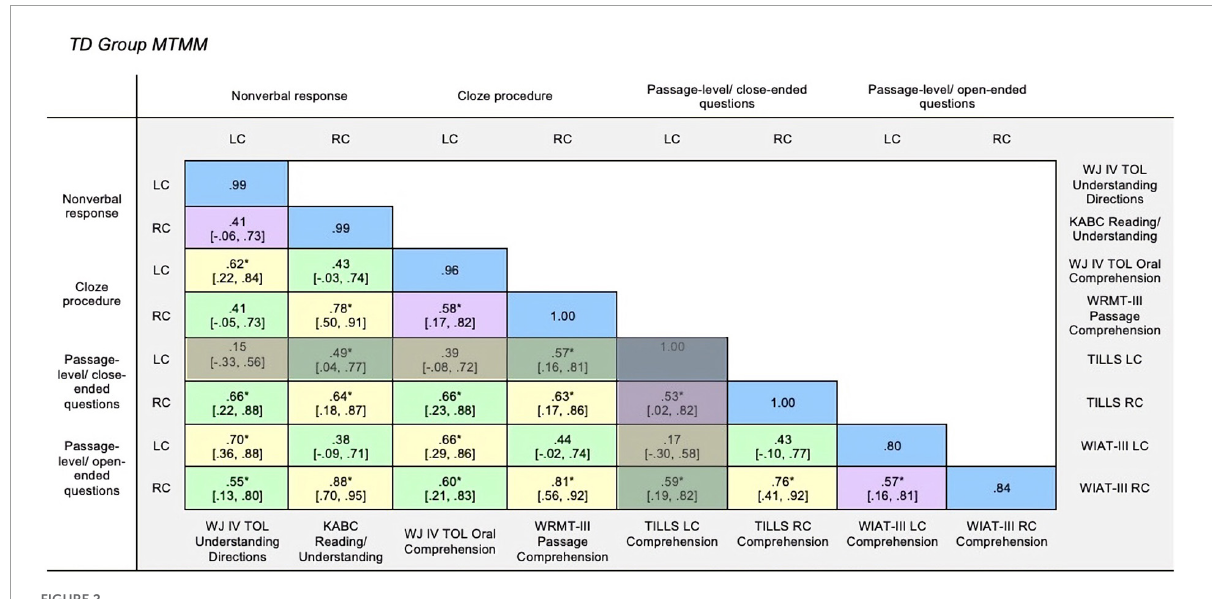
FIGURE2 TD group MTMM. Multitrait-multimethod matrix for Down syndrome group. Monotrait-monomethod cells (reliability diagonal) marked in blue, monotrait-heteromethod cells (validity diagonal) marked in yellow, heterotrait-monomethod cells marked in purple, and heterotrait-heteromethod cells marked in green. LC, Listening Comprehension; RC, Reading Comprehension; WJ IV TOL, Woodcock-Johnson Test of Oral Language IV (Schrank et al., 2014); KABC, Kaufman Assessment Battery for Children (Kaufman and Kaufman, 1983); WRMT-III, Woodcock Reading Mastery Tests-Third Edition (Woodcock, 2011); WIAT-III, Wechsler Individual Achievement Test-Third Edition (Wechsler, 2009). * p >